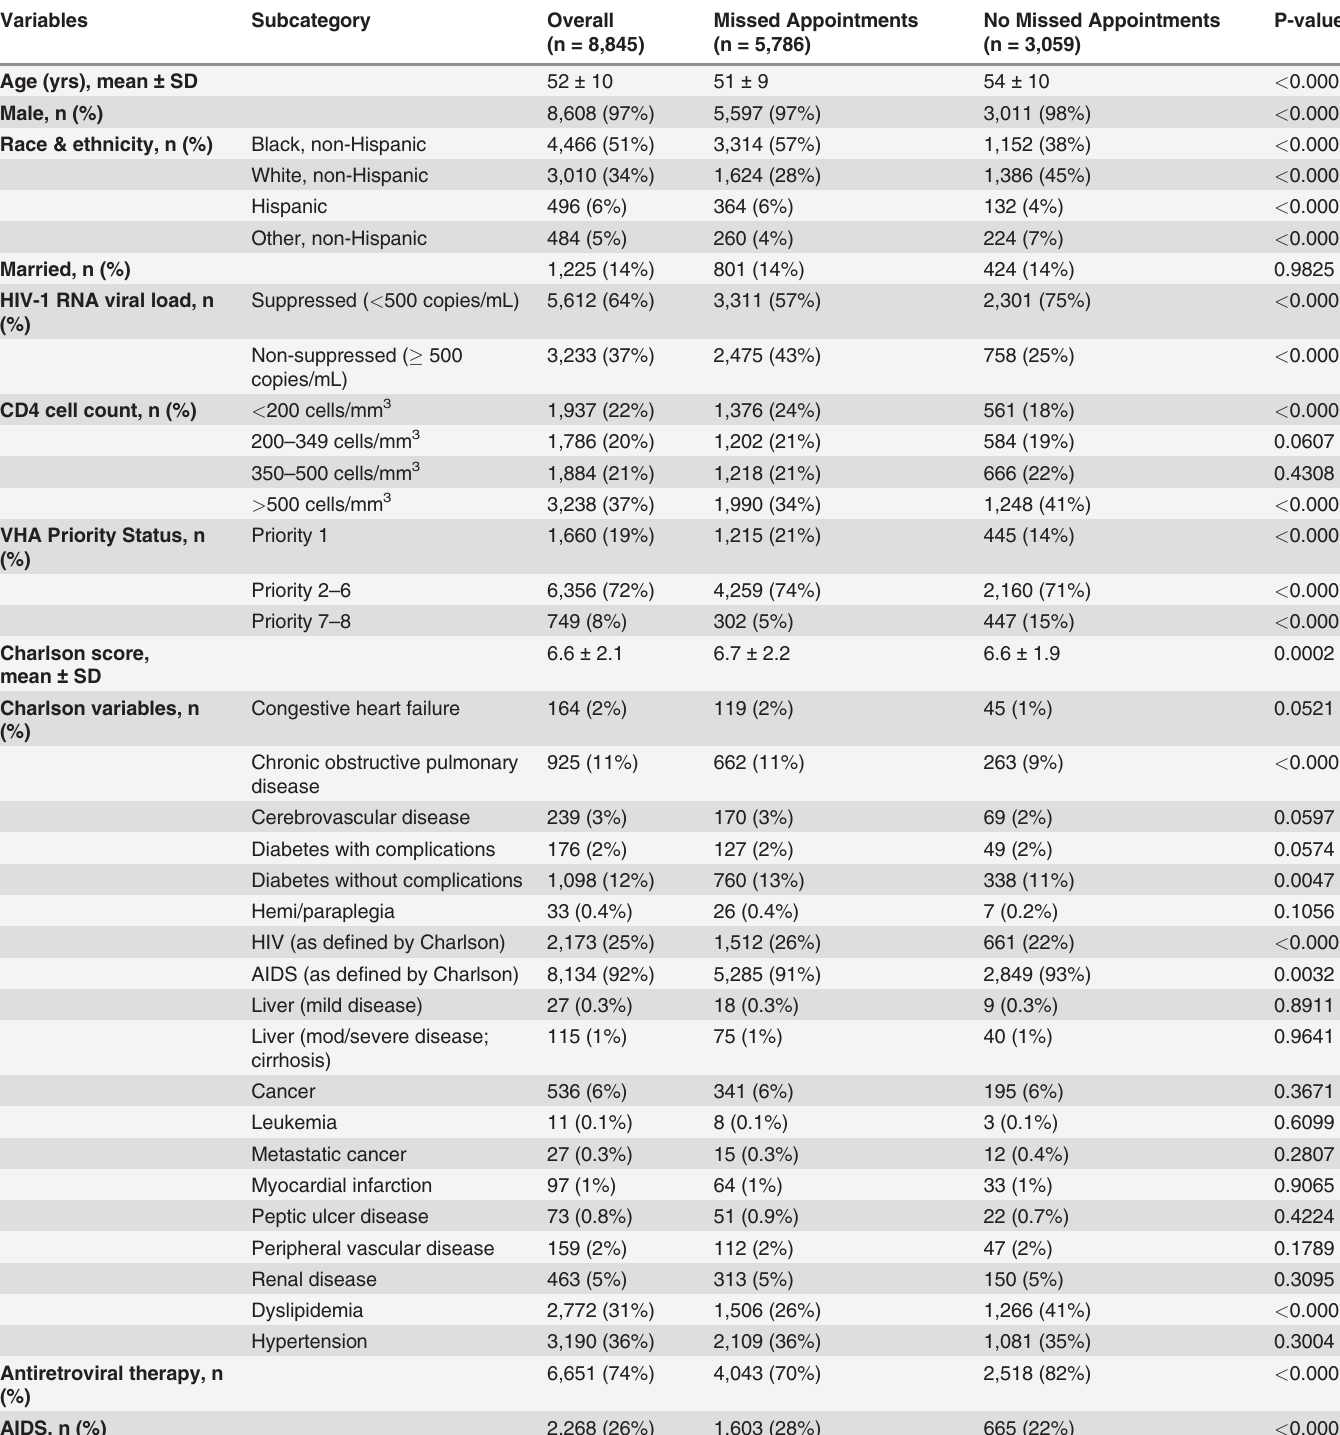
Table 1. Patient baseline